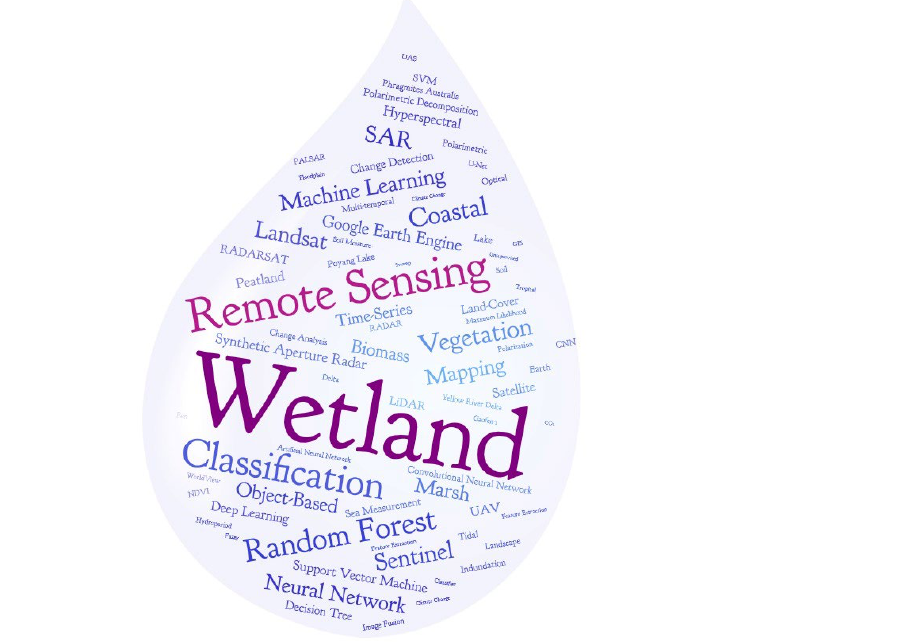
Figure 5. Word cloud shows the most frequent terms in wetland studies. The larger the text, the more frequently the word appeared in considered papers.